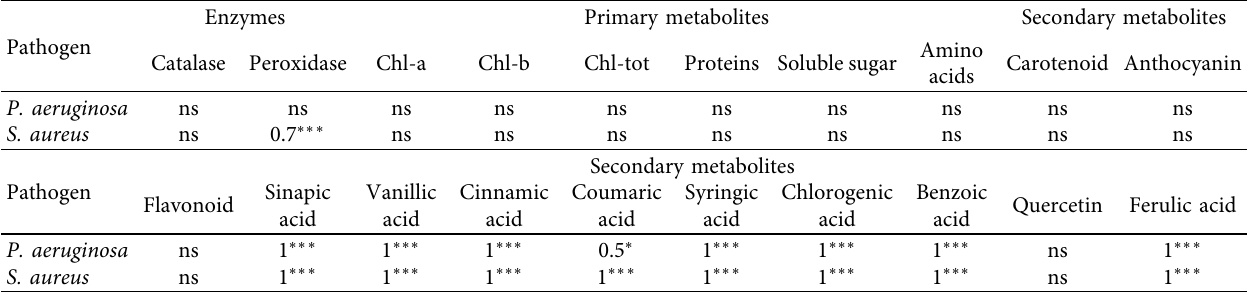
Table 3: Correlation matrix of leaf antimicrobial activity with enzymes, and primary and secondary metabolites of M. charantia . Pathogen